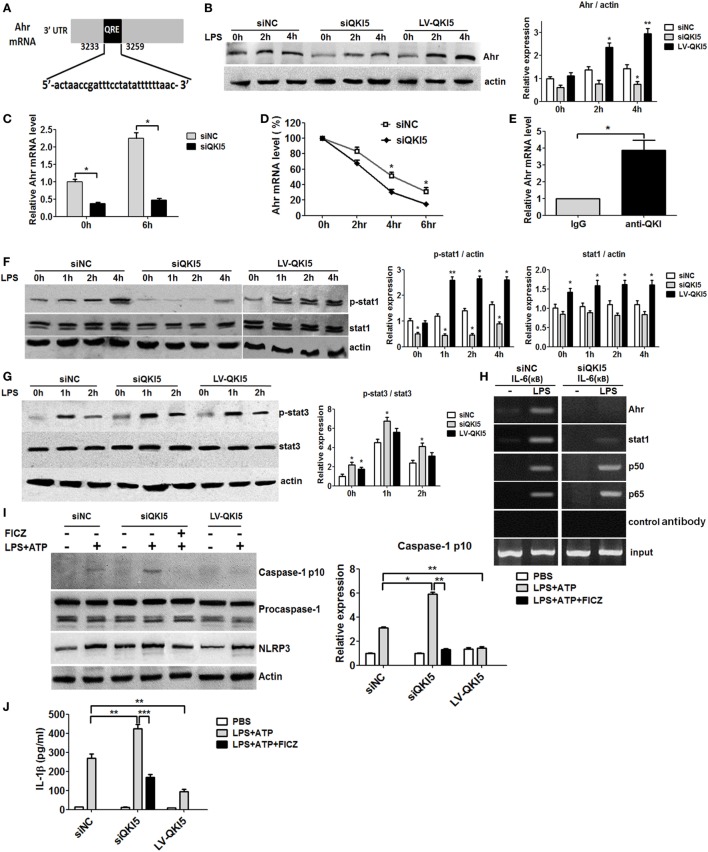
Inhibition of NF-κB transcriptional activity and inflammasome activation by quaking (QKI) was aryl hydrocarbon receptor (Ahr) dependent. (A) Bioinformatics analysis confirmed the QKI binding site in the 3′UTR of Ahr mRNA. Regions corresponding to a potential QKI response element (QRE) sequence are shown in shaded boxes. (B) QKI-silenced or overexpressed RAW 264.7 cells were stimulated with 1 µg/ml lipopolysaccharide (LPS) for the time indicated and subjected to western blot analysis. One representative immunoblot of Ahr is shown and the graph presents quantification of the band intensity for immunoblots from three independent experiments. (C) SiQKI5 or siNC cells were stimulated with or without 1 µg/ml LPS for the time indicated. The Ahr mRNA level was analyzed by real-time PCR. (D) The decay of Ahr mRNA in QKI knockdown or control RAW 264.7 cells. Six hours after LPS (1 µg/ml) stimulation, cells were washed with PBS for four times and incubated with new medium in the presence of actinomycin D to block transcription before isolating total RNA at the indicated time points of transcription inhibition. Real-time PCR was performed for the analysis of Ahr mRNA expression. *p < 0.05 versus scramble control. (E) RNA immunoprecipitation analysis using QKI antibody followed by real-time PCR to measure the mRNA levels of Ahr in RAW 264.7 macrophages treated by LPS for 6 h, with β-actin used as a normalization control. (F,G) Cells were stimulated with 1 µg/ml LPS for the time indicated and cell lysates were analyzed by immunoblotting with specific antibodies. One representative western blot of p-STAT1, total STAT1 (F), STAT3 and p-STAT3 (G) is shown. Graphs present the quantification of band intensity for immunoblotting from three independent experiments. (H) Cells were treated with 1 µg/ml LPS for 4 h and the ChIP assay was performed using anti-p65, anti-p50, anti-STAT1, and anti-Ahr antibodies. Purified DNA fragments were amplified using primers specific for the IL-6 promoter. One representative result from three independent experiments is shown. (I) Cells were pretreated with dimethyl sulfoxide or FICZ for 40 min and stimulated with LPS for 8 h and ATP for the last 30 min. Cell lysates were subjected to western blot analysis. One representative immunoblot of cleaved caspase-1 (p10), procaspase-1, and NLRP3 is shown. (J) Cells were treated as described in (I) and the levels of IL-1β in the culture supernatants were determined by enzyme-linked immunosorbent assay. All the bars represent the mean of measurements from three independent experiments, and the error bars indicate ±SEM. *p < 0.05, **p < 0.01.